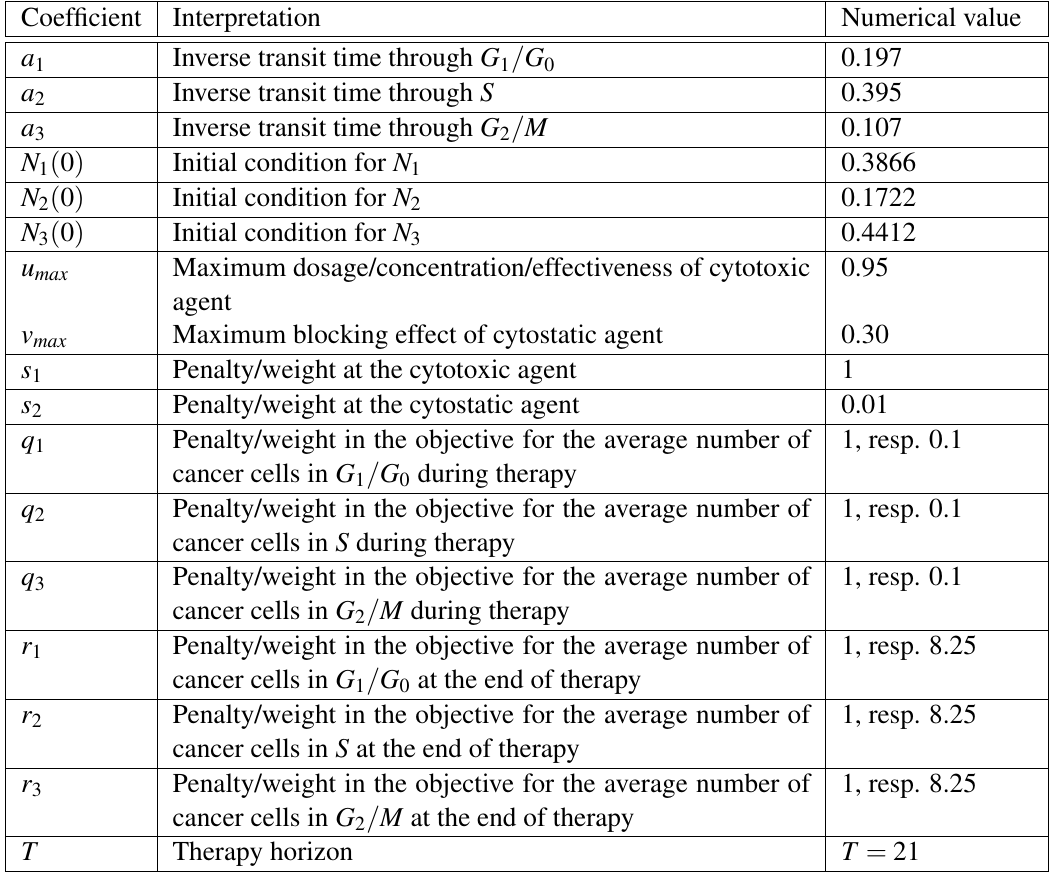
Table 3 Numerical values for the coefficients and parameters used in computations for the optimal control problem 3 with cytostatic and cytotoxic agents, extracted from